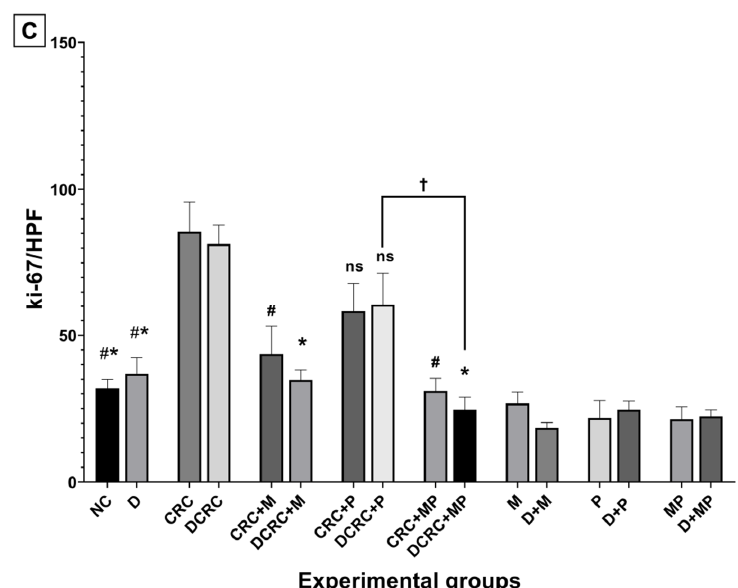
Figure 8. E ff ect of probiotics and metformin on colon proliferation. ( A , B ) Panel of representative images of colon section labelled with with Ki-67 (red) and counterstained with DAPI (blue) in nondiabetic ( A ) and diabetic groups ( B ). HPF 40 × magnification; scale bars 50 µ m. “L” indicates the position of the lumen. CRC and DCRC groups showed the highest positive nuclear Ki-67 staining throughout the crypts, with increased staining intensity from the midcrypt region to the lumen. A decrease proliferating cells was observed with probiotics and metformin administration to di ff erent extents. Normal controls and animals that were not subject to CRC induction had low proliferation indices; ( C ) Proliferation index in the di ff erent groups. Data is expressed as mean ± SEM ( n = 5). Nondiabetic groups were compared to their experimental CRC control (CRC), significance was expressed by # p < 0.05. On the other hand, diabetic groups were compared to their experimental diabetic CRC control (DCRC); significance was expressed by * p < 0.05. Moreover, when comparing only two groups, connecting lines were used to indicate the compared groups with † p < 0.05; ns stands for nonsignificant.